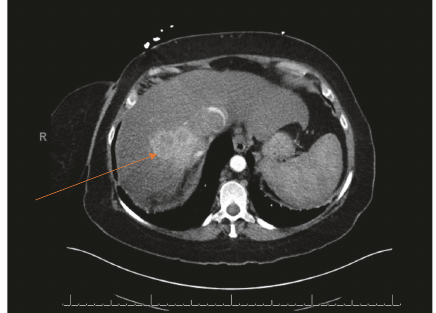
Figure 2: Liver metastases.